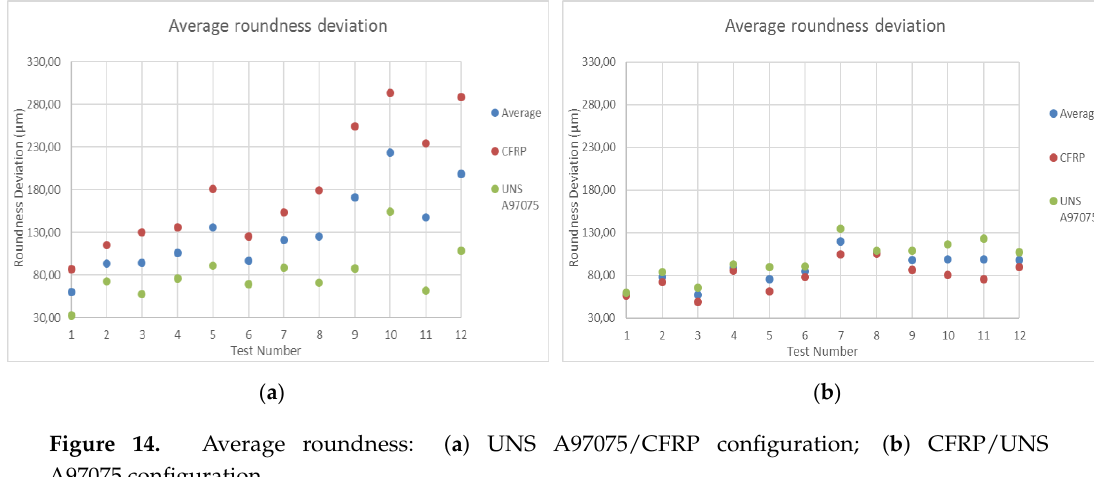
Figure 14. Average roundness: ( a ) UNS A97075/CFRP configuration; ( b ) CFRP/UNS A97075 configuration.